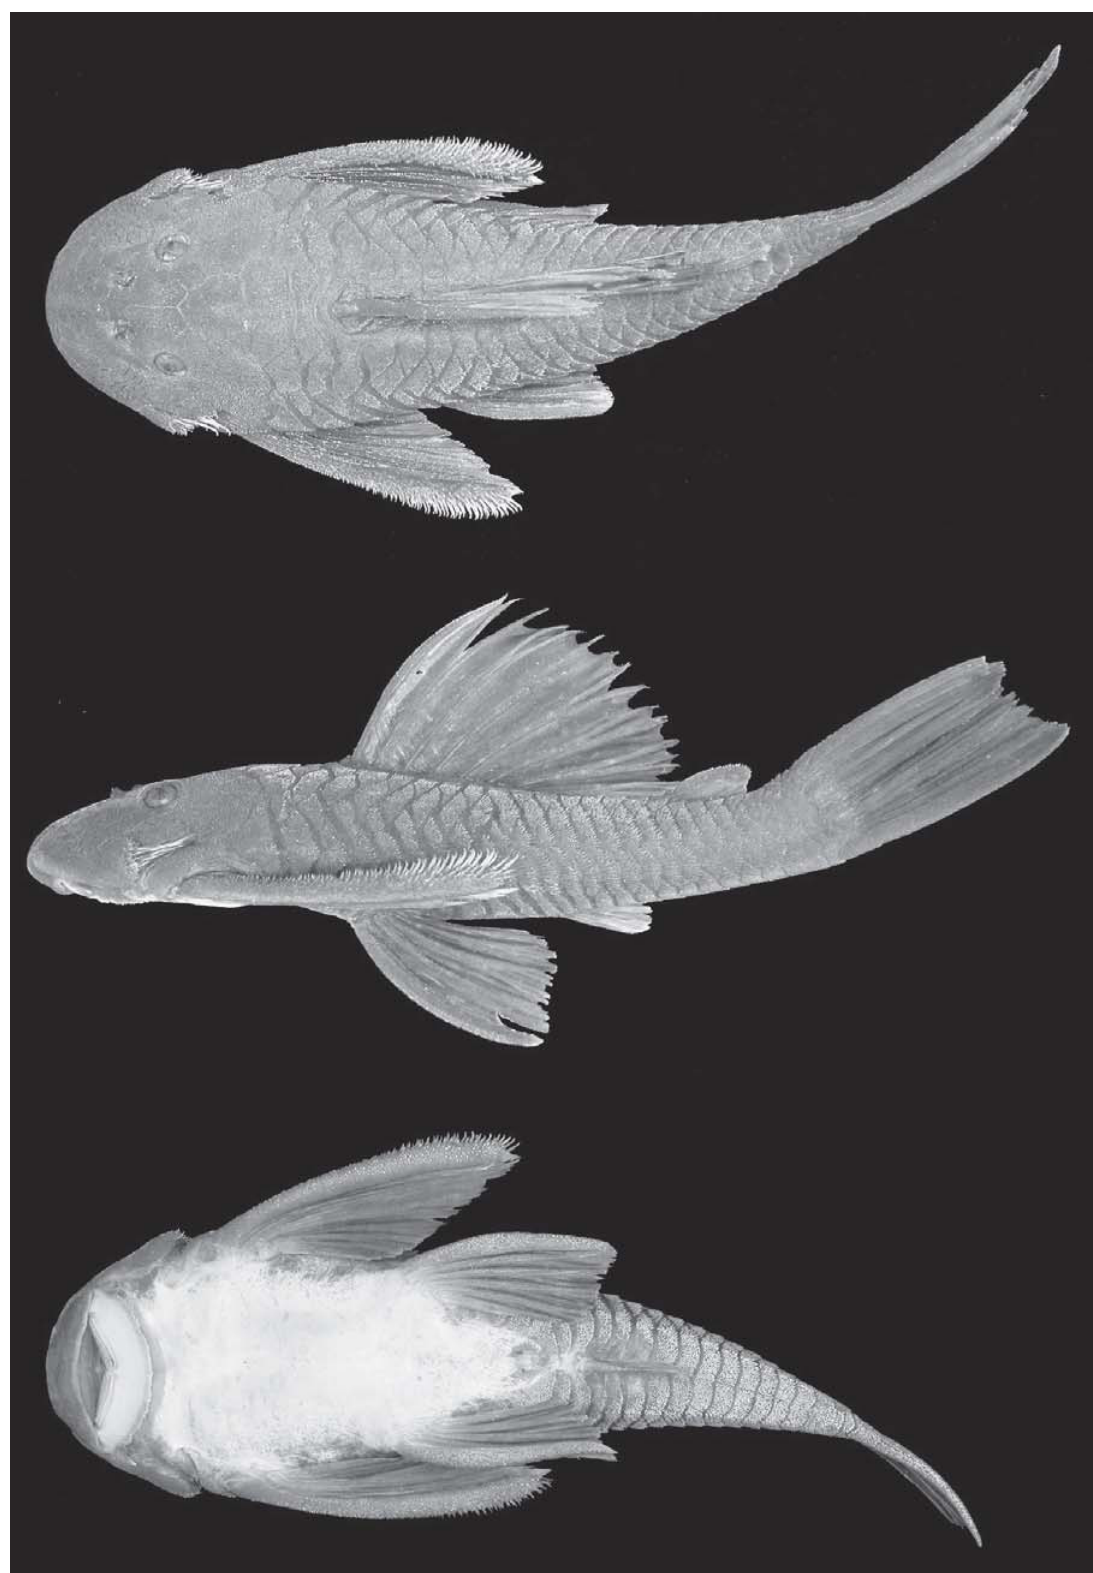
Fig. 1. Hemiancistrus votouro , holotype, MCP 33594, female, 133.9 mm SL, arroio Lageado Grande, about 2.5 km NE from Votouro Indian Reserve (tributary of the rio Passo Fundo, rio Uruguai basin), Benjamin Constant, Rio Grande do Sul,